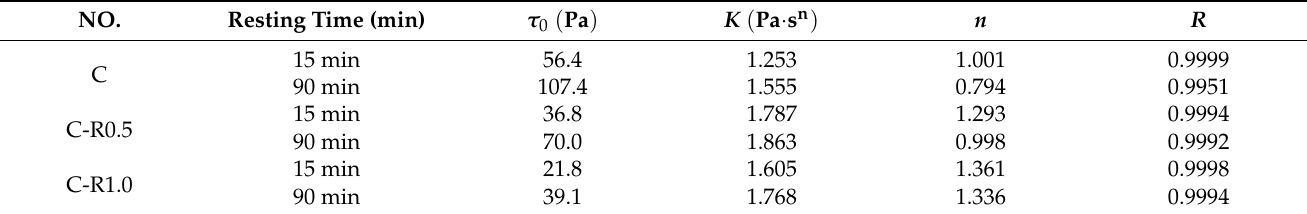
Table 7. Rheological parameters of C-RPP pastes.